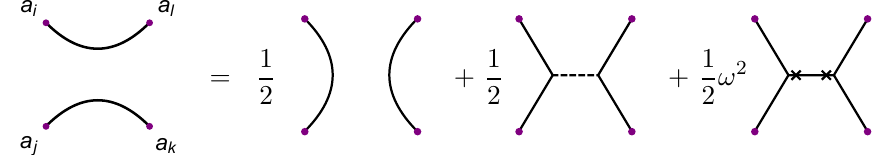
Figure 48 . The crossing equation on the four-point function of the defect operator a i .